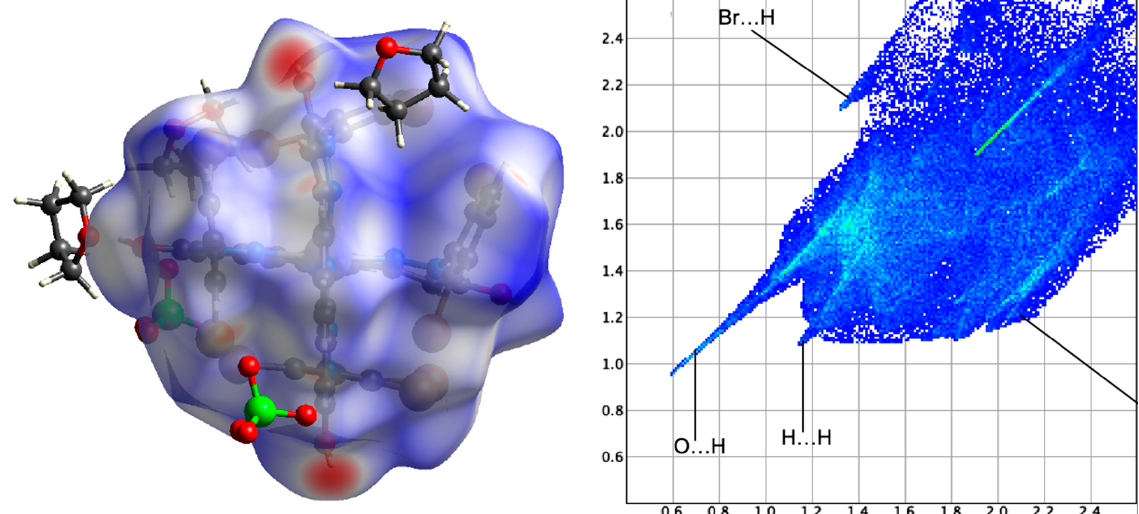
Figure 7. Hirshfeld surface ( left ) of the cation in [Fe( L H ) 2 ](ClO 4 ) 2 and its 2D fingerprint plot ( right ) as generated by Crystal Explorer [79]. On the Hirshfeld surfaces ( left ), intermolecular interactions with interatomic distances below, equal, or above a sum of van-der-Waals radii are shown by red, white, and blue areas, respectively. Green and blue areas on 2D fingerprint plots ( right ) stand for higher and lower concentration of points corresponding to (di, de) pairs. For [Fe( L Br ) 2 ](ClO 4 ) 2 and [Fe( L Me ) 2 ](ClO 4 ) 2 , see Figure S9 of ESI.